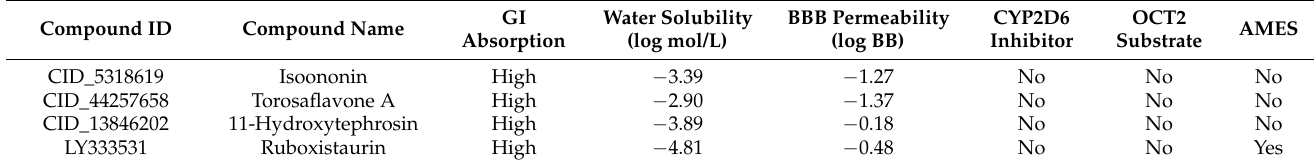
Table 2. The ADMET parameters of the selected molecules using the pkCSM Web tool.